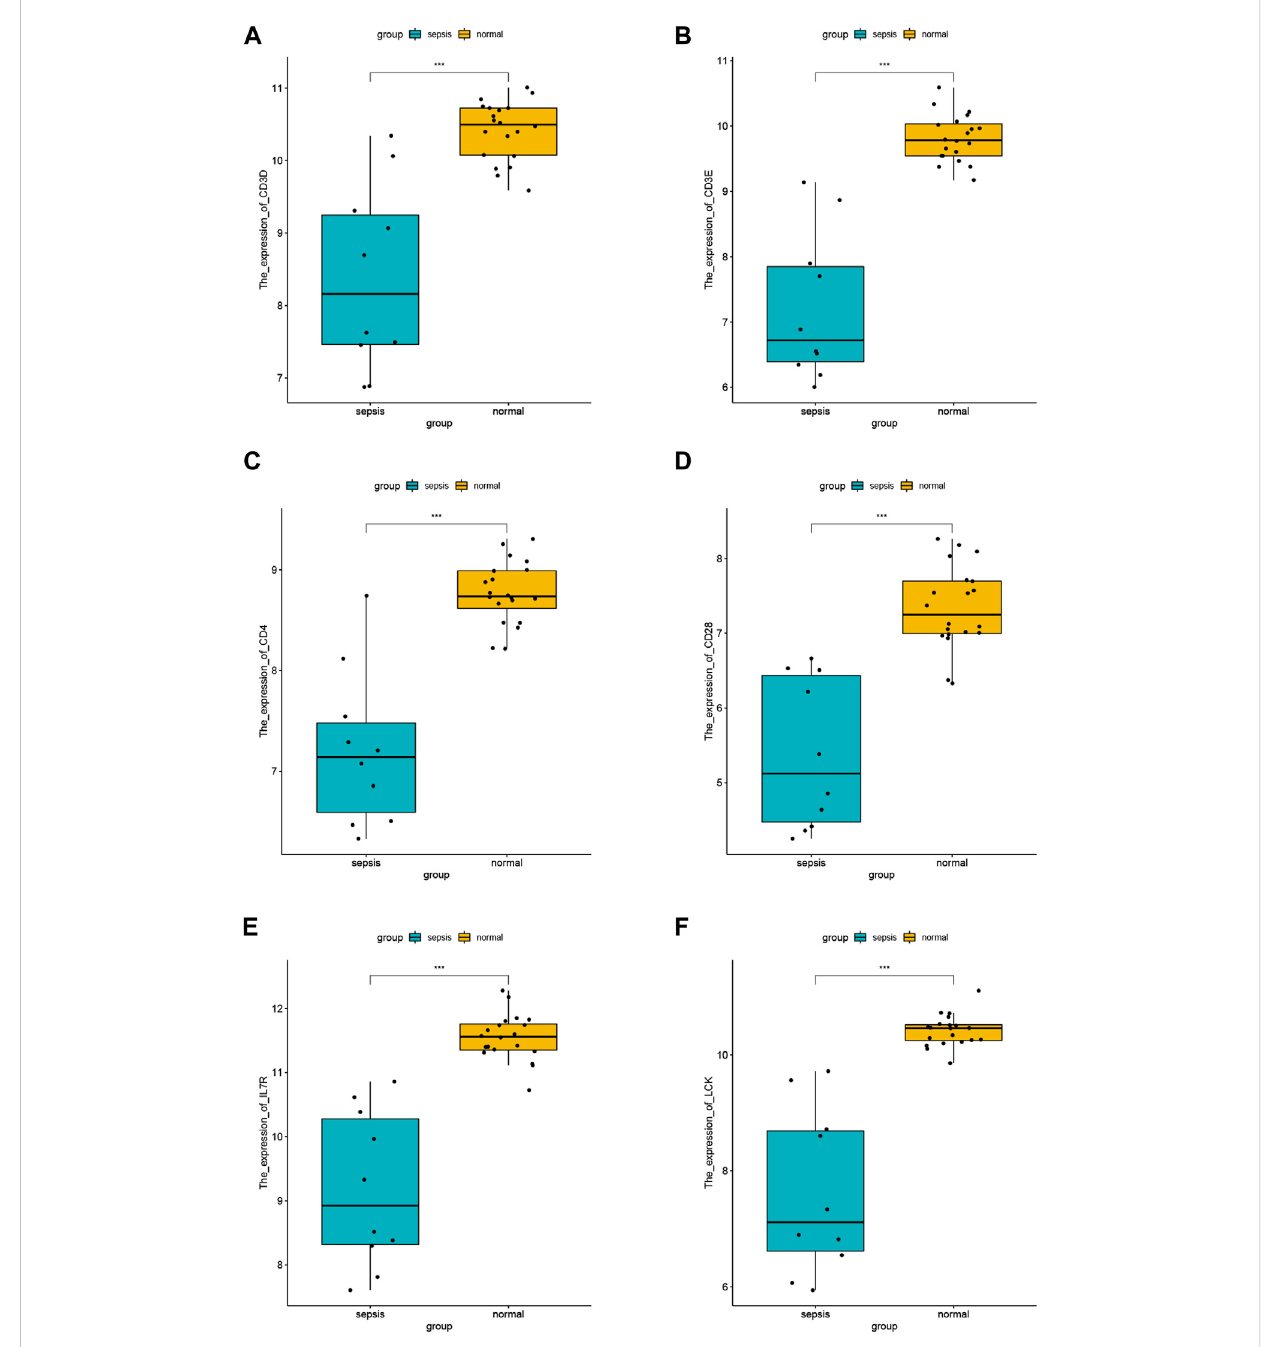
FIGURE 6 Differentialanalysisofhubgene. (A) Expression differenceofCD3DinGSE28750betweensepsisgroupandcontrolgroup. (B) Expression difference of CD3E in GSE28750 between sepsis group and control group. (C) Expression difference of CD4 in GSE28750 between sepsis group and control group. (D) Expression difference of CD28 in GSE28750 between sepsis group and control group. (E) Expression difference of IL7R in GSE28750 between sepsisgroupandcontrolgroup. (F) ExpressiondifferenceofLCKinGSE28750betweensepsisgroupandcontrolgroup.* p < 0.05; pp p < 0.01; ppp p <